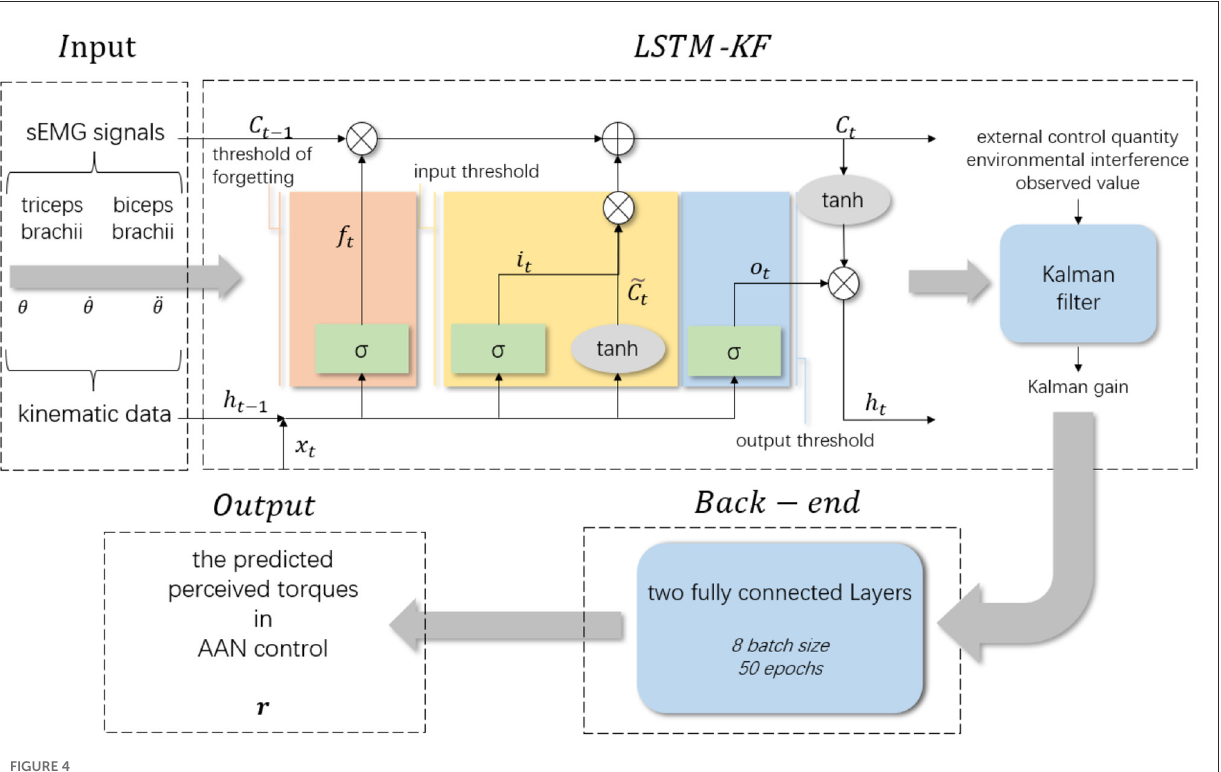
FIGURE4 The framework of the regression model.